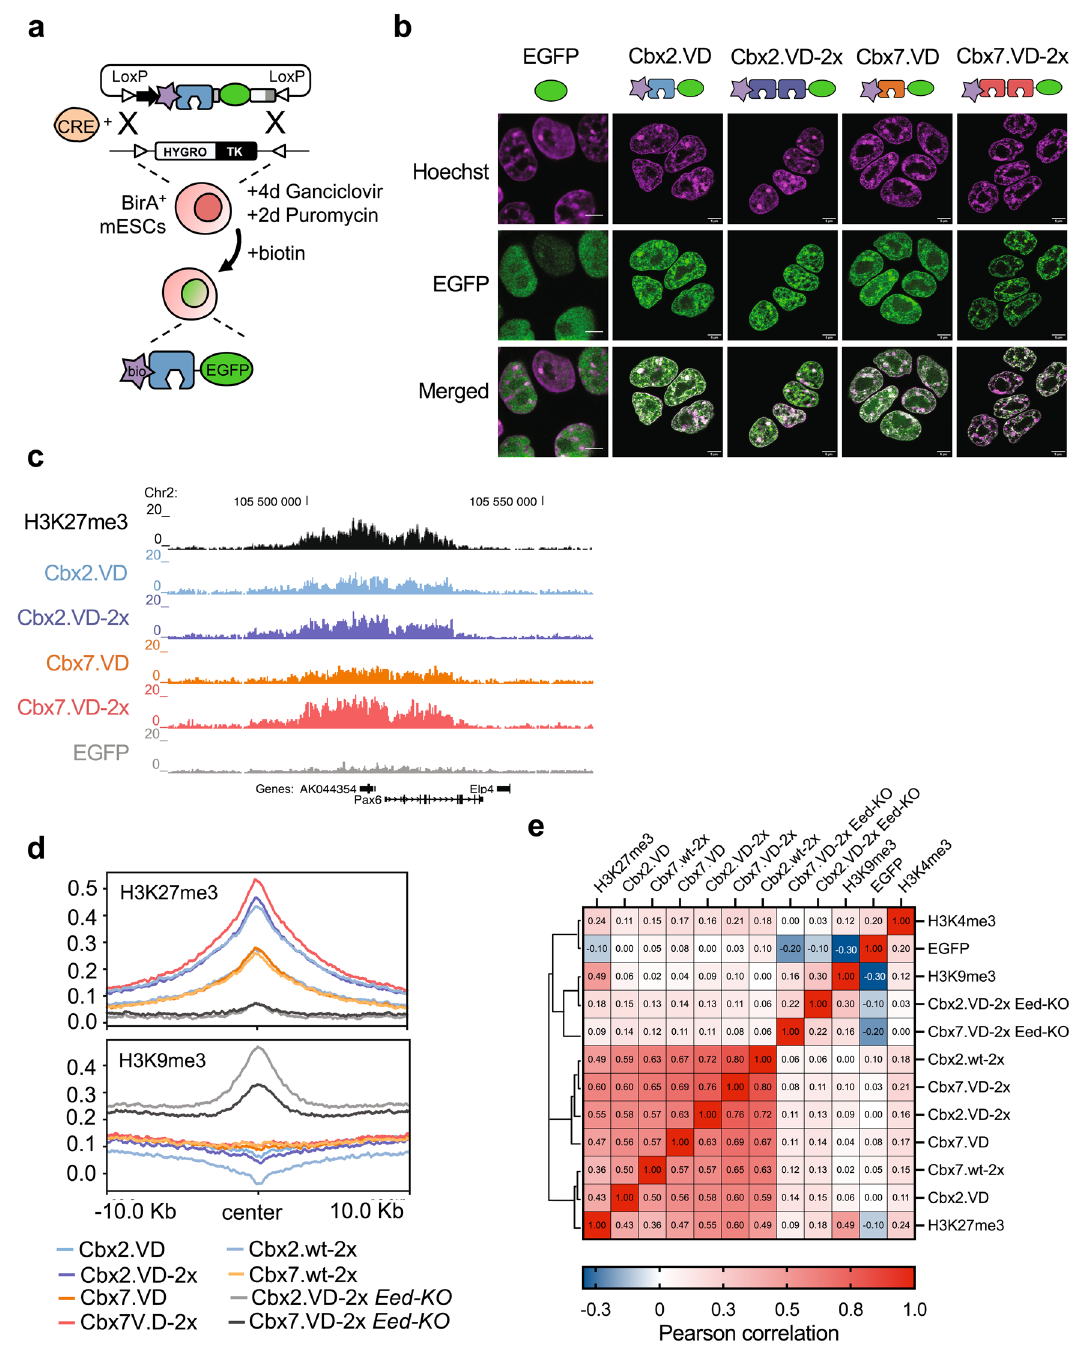
Fig. 3 | Functional characterization of engineered chromodomains in mESCs. a Schematic representation of RCME strategy for site-speci fi c integration of monovalent and bivalent Cbx chromodomain variants in the genome of mESCs. Site-speci fi c biotinylation of stably integrated chromodomains was performed in vivo by the enzymatic activity of an E.coli biotin ligase (BirA). b Live-cellimaging of mESCs expressing Cbx7.VD and Cbx2.VD chromodomains arranged in single- domain or double-domain con fi guration. NuclearEGFP wasusedasa control.Data showrepresentativeconfocalimagesfromtwoindependentexperiments.Scalebar 5 µ m. c Genome browser example showing correct localization of engineered chromodomains at a H3K27me3 genomic region detected by antibody ChIP – seq. Shown is the bigWig coverage-track at 100-bp intervals and normalized to Reads Per Kilobase per Million mapped reads (RPKM). Gene models are indicated. d The top panel shows average density pro fi les of EGFP-fused chromodomains centered